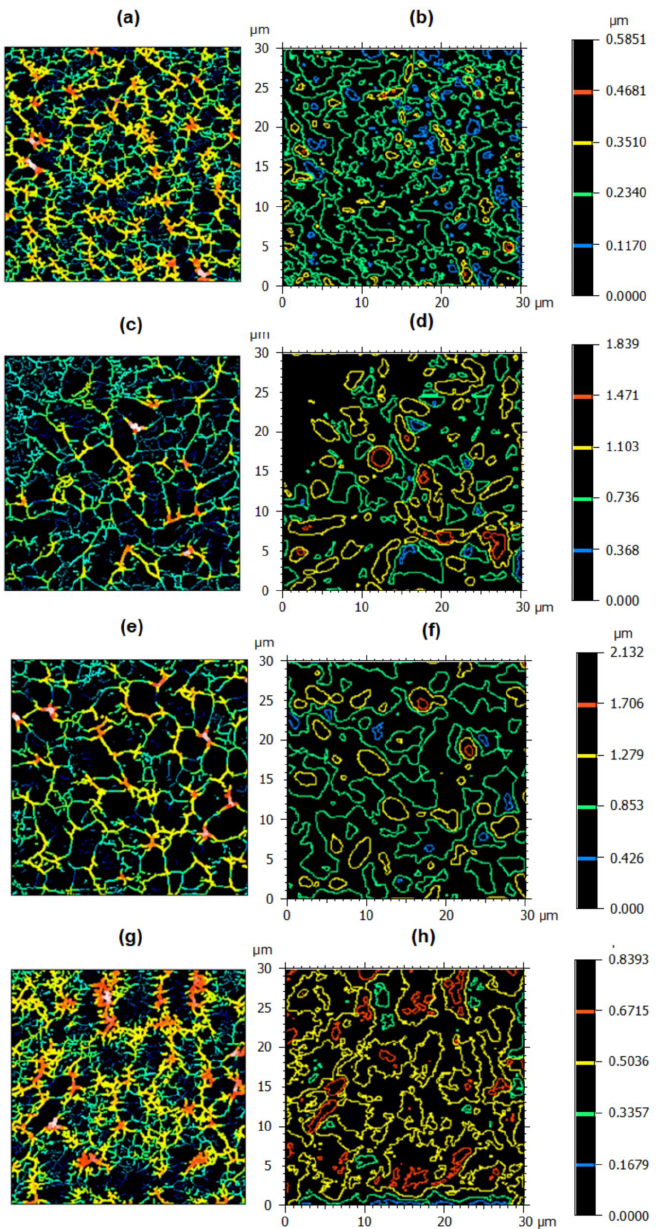
Figure 5. Graphical representations of the furrows and lines contours for a,b) Bio0, c,d) Bio25, e,f) Bio50, and g,h) and contour lines for each biofilm, respectively. It was observed that the addition of the plant extract promoted changes in the presentation of the furrows and contours. The furrows and contours for the biofilm without the extract ( Figures 5a and 5b) were smooth, with the distribution of micro-furrows showing dispersed throughout the exopolysaccharide matrix. The contour lines ( Figures 5b, 5d, 5f, and 5h) also revealed how the surfaces can behave when they are flooded by some fluid. Some macro- regions would be more exposed to higher concentrations of the plant extract.